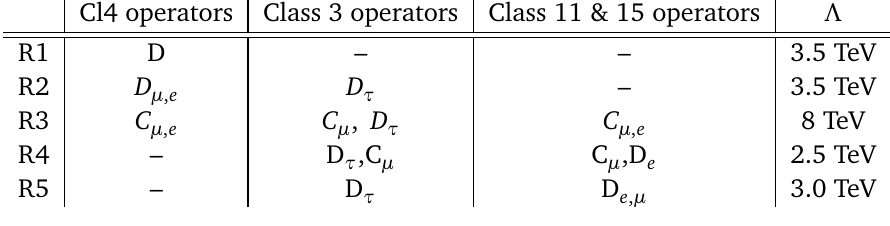
indicates this operator class domi- i indicates that there is no dominant i